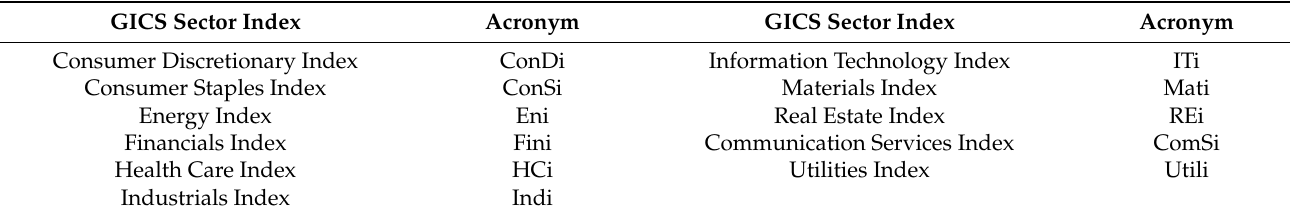
Table 1. Sector name and corresponding